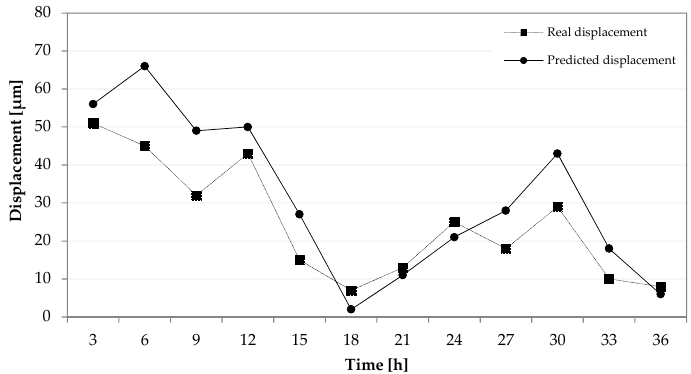
Figure 9. Thermo ‐ mechanical effects: the real tool tip displacement vs. the predicted displacement. Table 2. A comparison between the main advantages and limitations of the FBG sensor application. Advantages